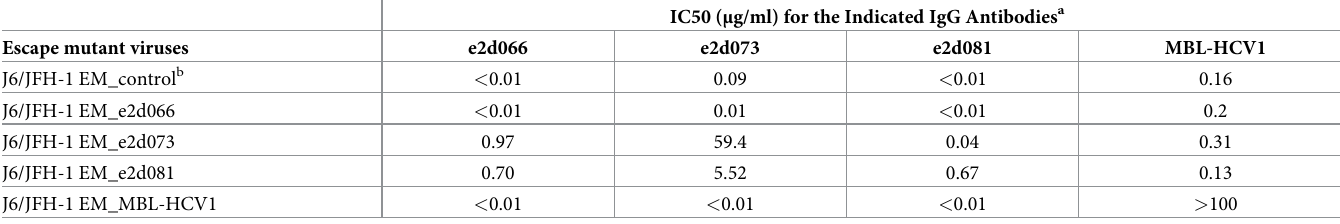
IC50 ( μ g/ml) for the Indicated IgG Antibodies a